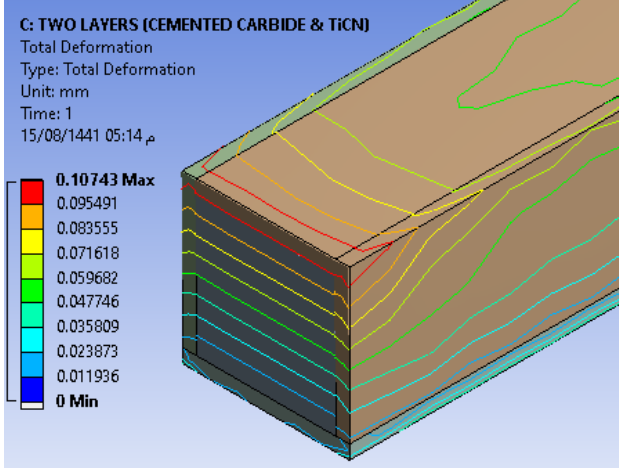
Fig. 23. Modeling of cemented carbide covered all by TiCN Fig. 26. Total information (0.019424 mm) at the thermal thickness of 1 mm condition for the whole body 500 °C and normal force 250